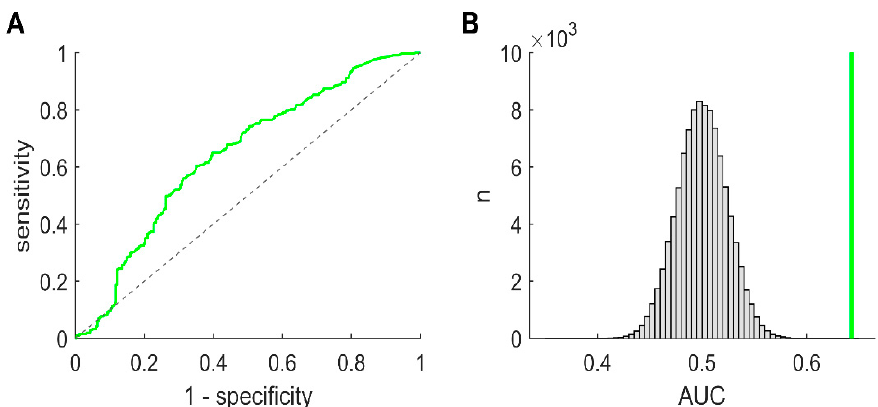
Figure 4. Delineation of eloquent neocortex based on ‘pure’ ripples—across patients. ( A ) ROC curve, functional vs. remaining non-SOZ classification, channels pooled across patients. ( B ) To investigate whether ‘pure’ ripples identify eloquent regions significantly better than chance, we again applied permutation-based testing. The probability of obtaining an AUC that is as high as or higher than our empirically measured value (bold vertical line) by chance (grey bars represent surrogate data) was less than 5% (two-tailed p < 0.001).